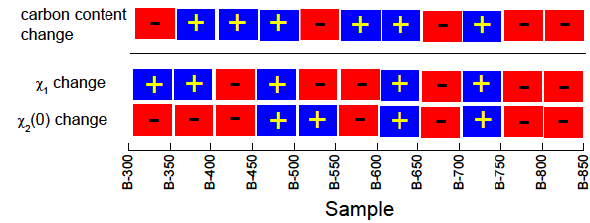
Figure 4: Carbon content change (upper row) and changes of val- ues of two susceptibility components (middle and bottom row) in comparison to a neighbouring sample (with annealing temperature bigger by 50 K). Increase of carbon content and susceptibilities from sample to sample are indicated by + sign and blue colour, decrease of carbon content and susceptibilities by − sign and red colour.